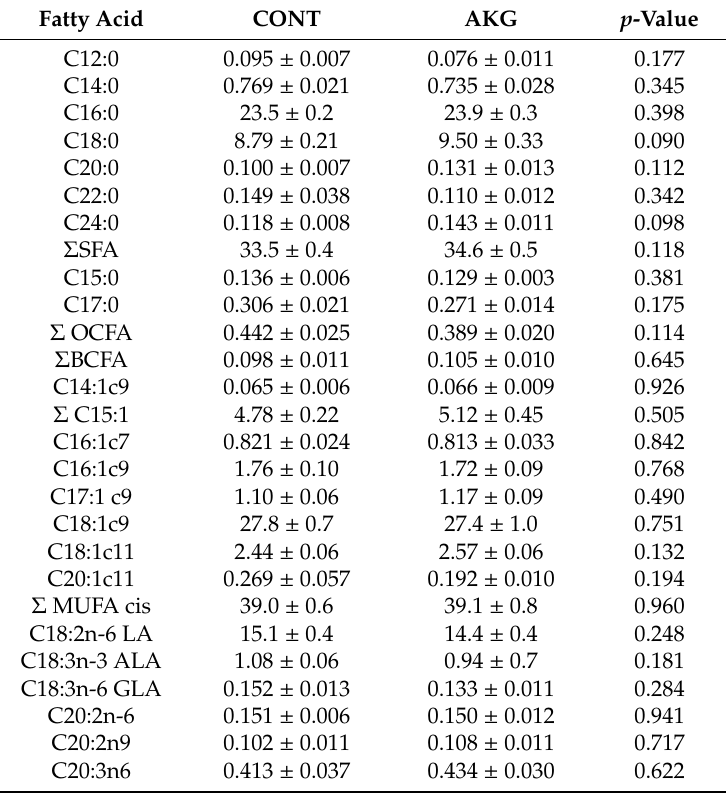
Table 5. The influence of AKG supplementation during the experimental period (31–60 weeks of age) on muscle fatty acid profile in laying hens at the age of 60 weeks, % of total fatty